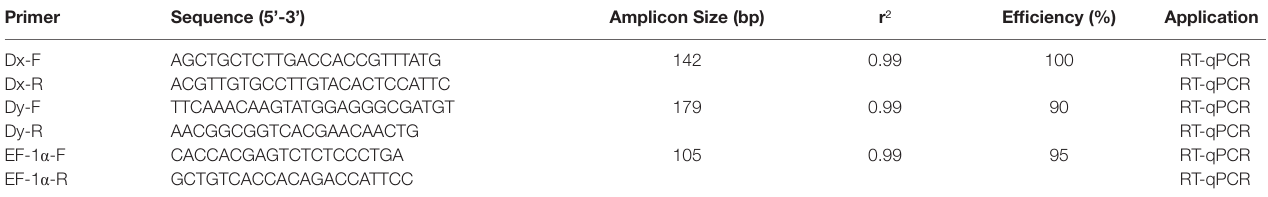
TABLE 2 | List of the primers used in real-time quantitative PCR (RT-qPCR) in this study. Primer Sequence